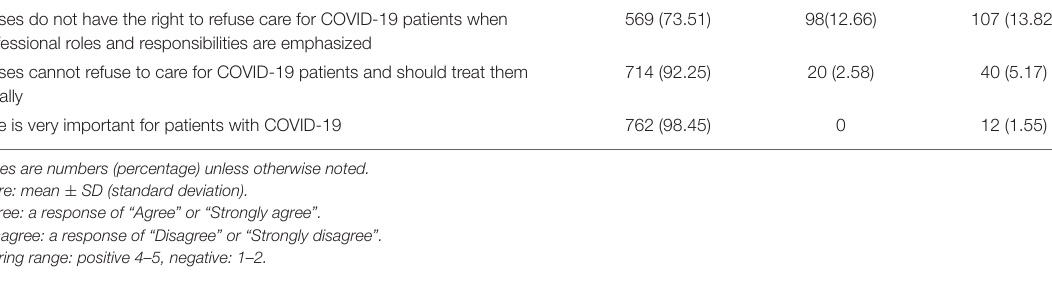
TABLE 2 | Respondents’ beliefs about the rights and interests while caring for COVID-19 patients ( n = 774). Variable Agree a Disagree b Neutral Score COVID-19 patients have the right to expect the same quality of healthcare as other patients Nurses have the right to refuse care for COVID-19 patients